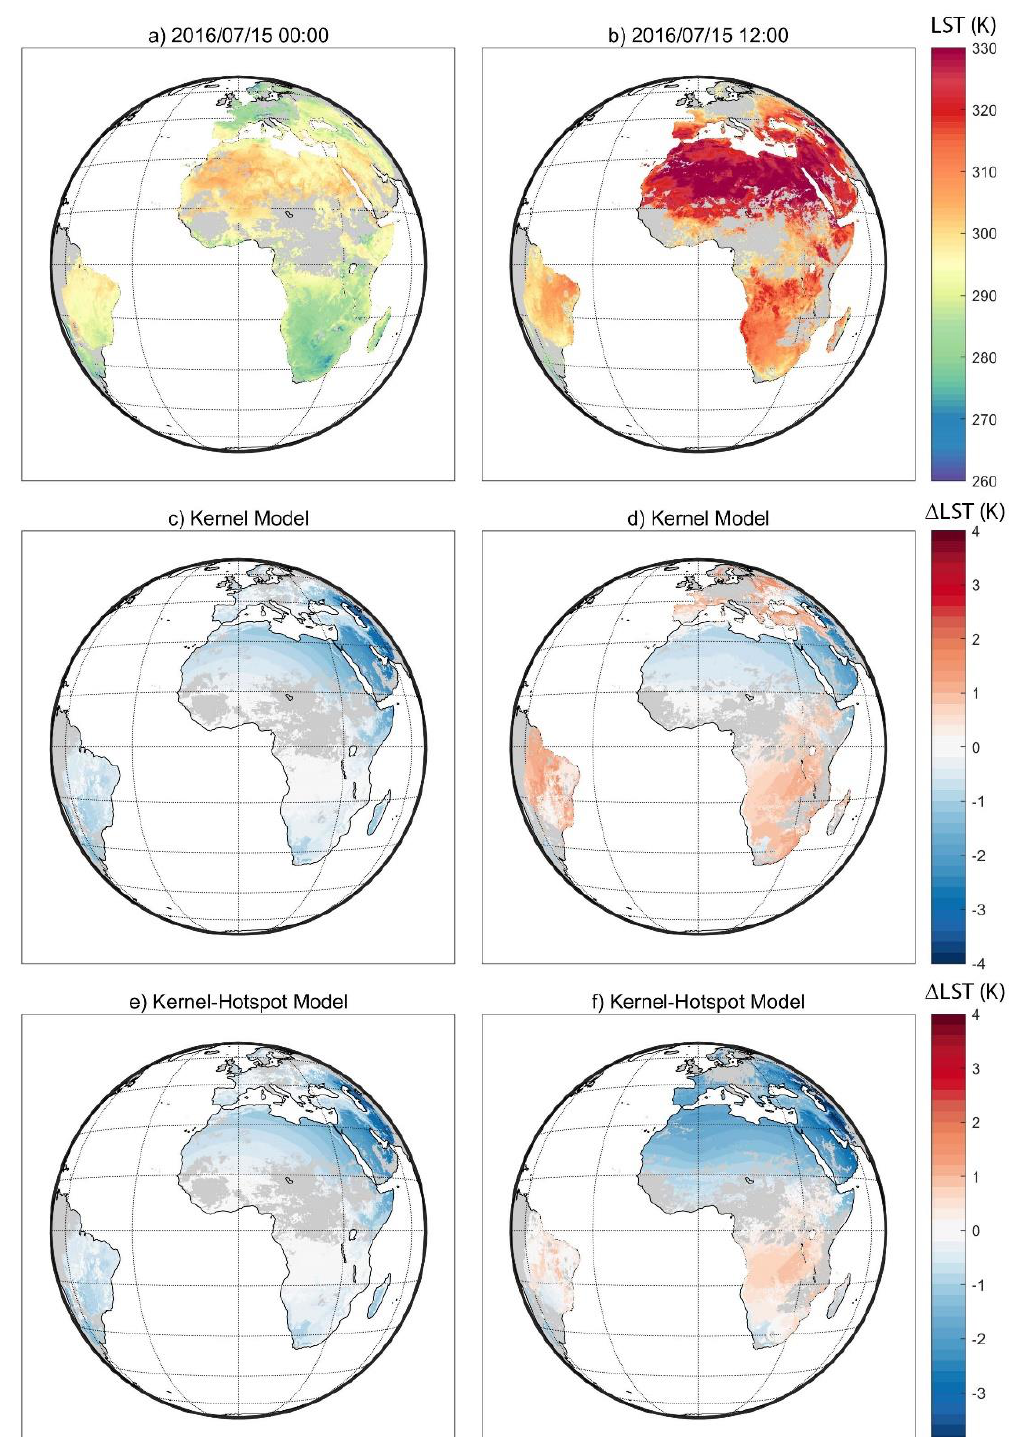
Figure 9. Examples of LST ( a , b ) as retrieved by SEVIRI and respective angular corrections to nadir (T-T 0 = ∆ LST) as given by the Kernel model ( c , e ) and the Kernel-Hotspot model ( d , f ), for the 15th of July of 2016 at 00:00 UTC ( a , c , e ) and 12:00 UTC ( b , d , f ). Cloudy land pixels are represented in grey.